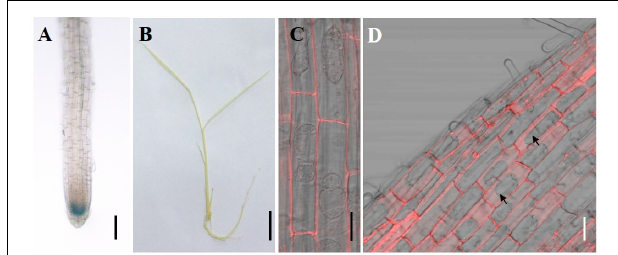
FIGURE 3 | Tissue specificity expression and subcellular localization assay. (A,B) Histochemical assay of CAL2 promoter GUS activity in 14-day-old rice seedlings. (C,D) Subcellular localization of CAL2 in Arabidopsis (C) and rice (D) plants harboring the construct 35S:CAL2-mRFP . 7-day-old seedling root epidermal cells were incubated in 40% sucrose to induce plasmolysis and then imaged by confocal microscopy. The arrows indicate the plasmolyzed